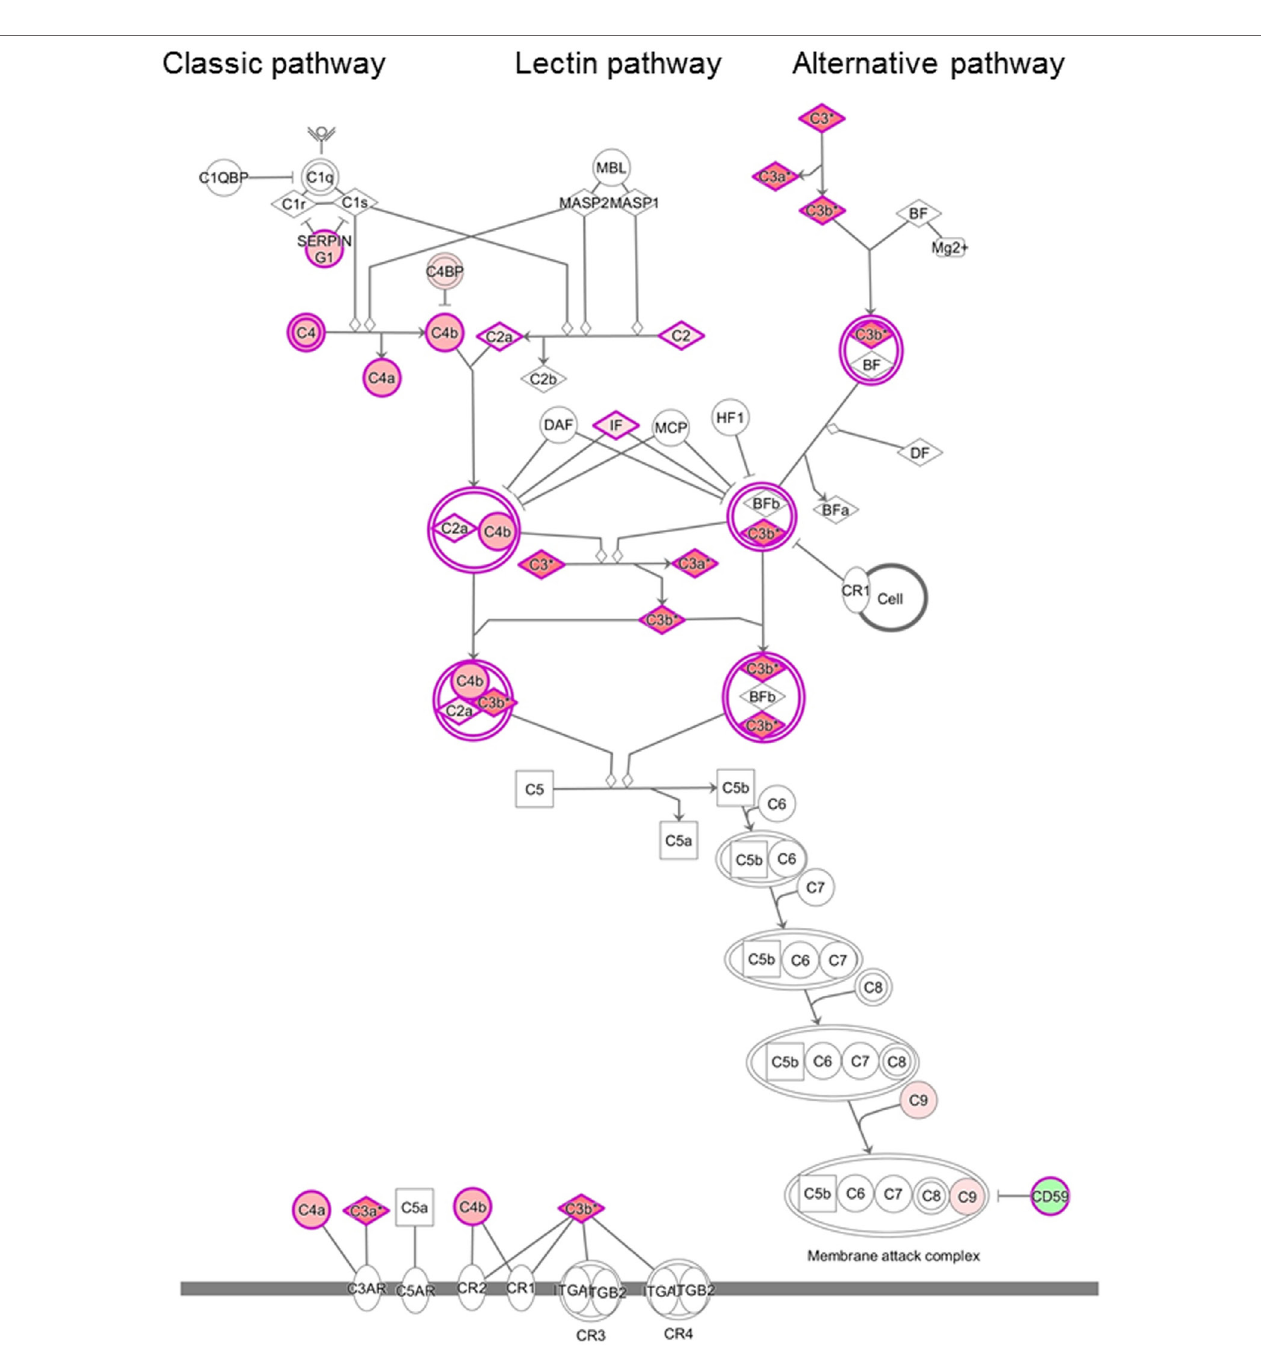
FigUre 2 | Differentially regulated complement pathways in the cerebrospinal fluid (CSF) of patients with chronic lymphocytic inflammation with pontine perivascular enhancement responsive to steroids (CLIPPERS). Ingenuity Pathway Analysis of the complement system in the CSF of patients with CLIPPERS. Red color indicates upregulation, green color indicates downregulation (see also Table 2 and Tables S1–S3 in Supplementary